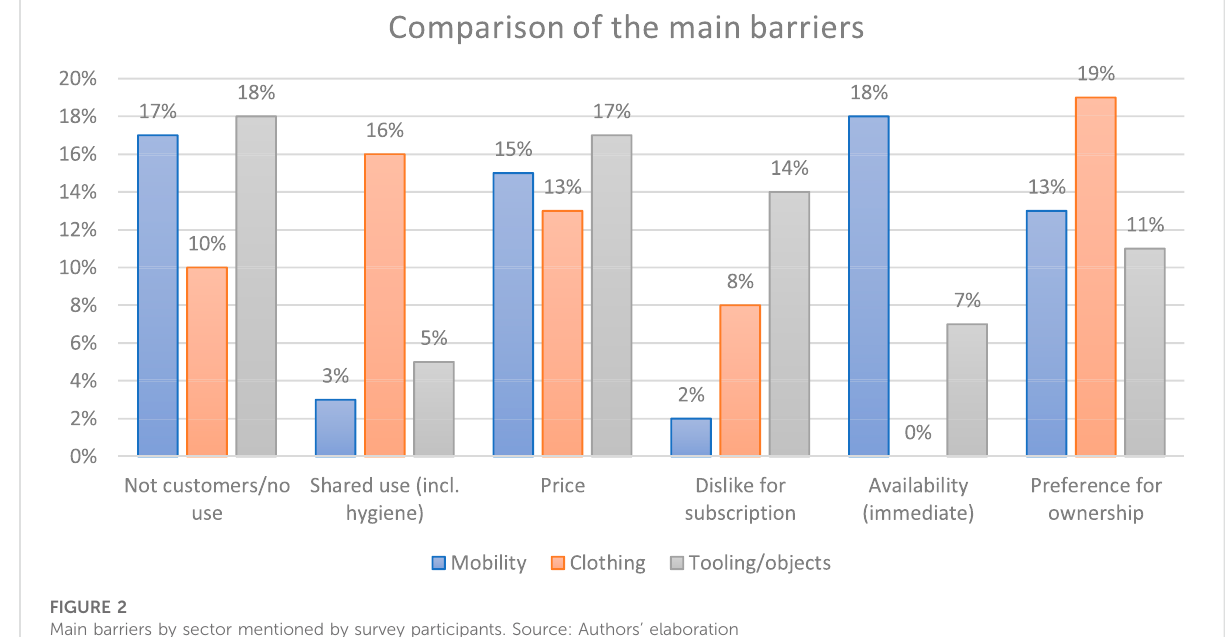
FIGURE 2 Main barriers by sector mentioned by survey participants. Source: Authors ’